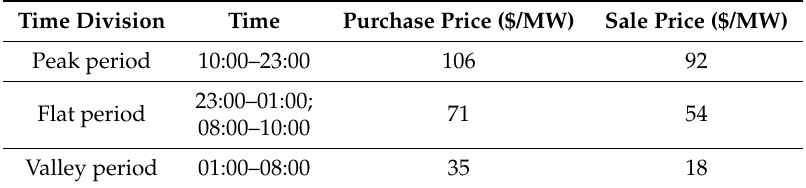
Table 1. The table of TOU